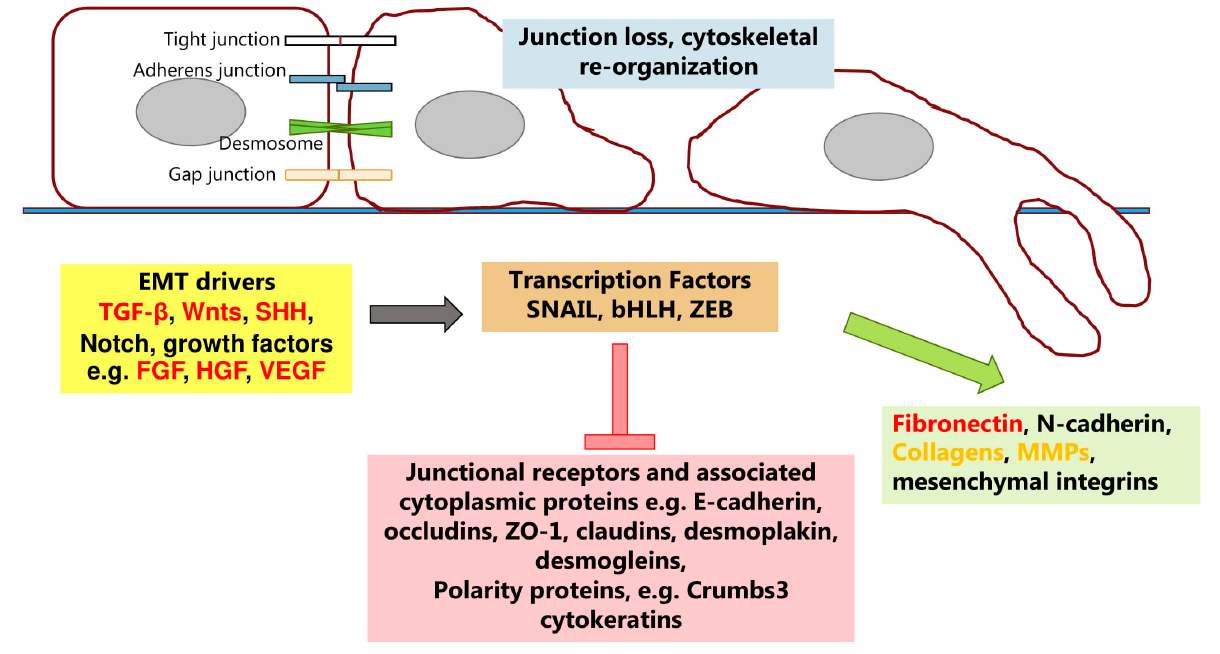
Figure 3. Schematic of some factors involved in epithelial–mesenchymal transformation (EMT). Polypeptides that promote EMT do so through transcriptional mediators that inhibit junctional and polarity protein expression but promote expression of proteins associated with a mesenchymal phenotype. Further detailed information can be found in [41,43–47]. Proteins that bind heparin/heparan sulfate are shown in red. Orange text denotes protein families where some members bind heparin or heparan sulfate.